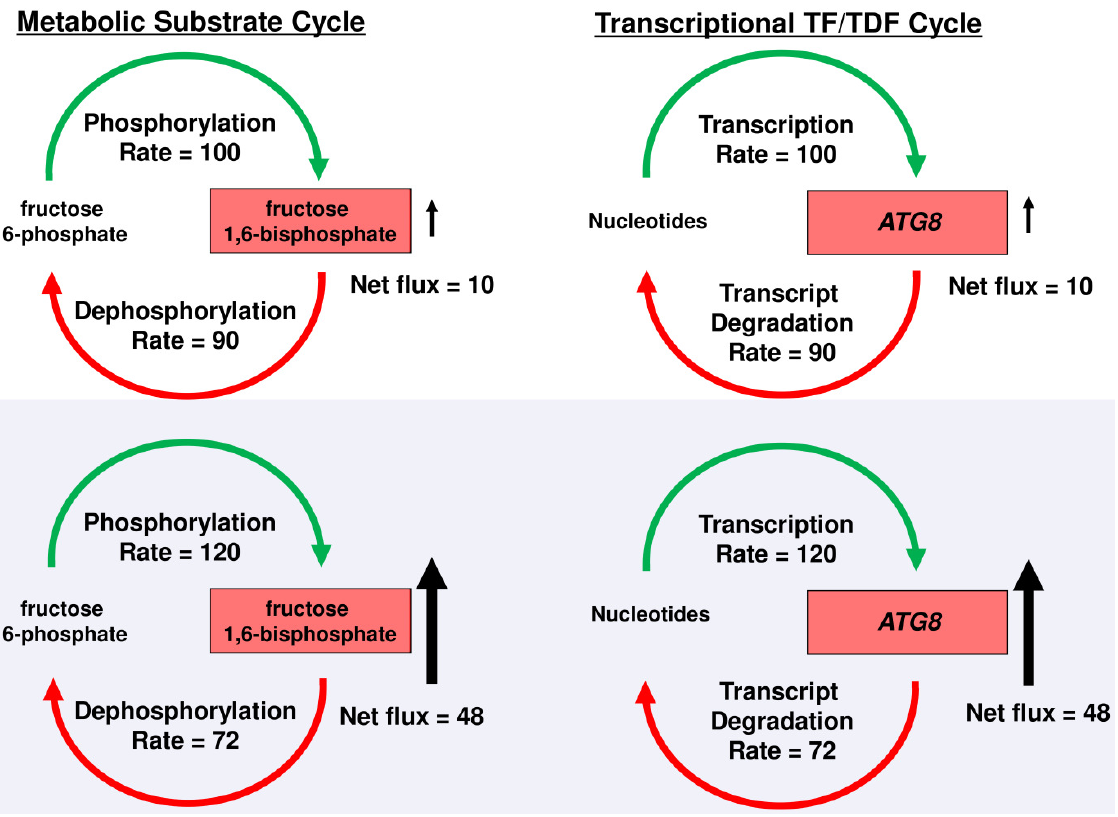
FIGURE 1: Efficiency of metabolic and transcriptional “futile cycles”. Top panels illustrate repressive conditions for the generation of fruc- tose 1,6-bisphosphate (resting muscle) and ATG8 transcripts (nutrient-replete conditions), respectively. Lower panels illustrate the corre- sponding inductive conditions, active muscle contraction and starvation, respectively. This figure was modified from figure 7 of Park et al. , (2010) J. Biol. Chem.